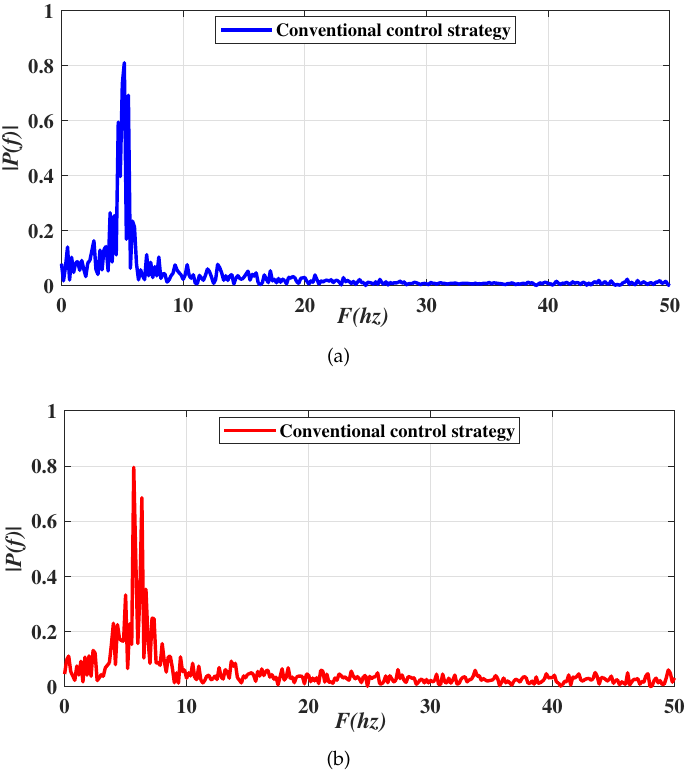
Figure 9. Transformed results of tracking error under conventional composite control strategy. ( a ) Reference = 20 nm. ( b ) Reference = 50